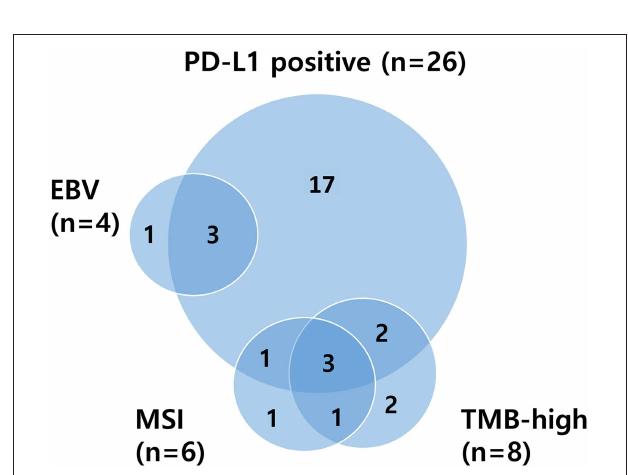
TP53 + GS − (SNVs in genes other than TP53 ; n = 6), and GS (no genetic alteration; n = 24). Patients with MSI tumors (median, 74.5 years) were the oldest. All patients with EBV-positive and MSI gastric cancer were male. PD-1 positivity was the highest in the EBV group (75%) and the lowest in the GS group (20.8%). Median TMB was the highest in the MSI group (21.92) and according to molecular subtypes are presented in Table S5